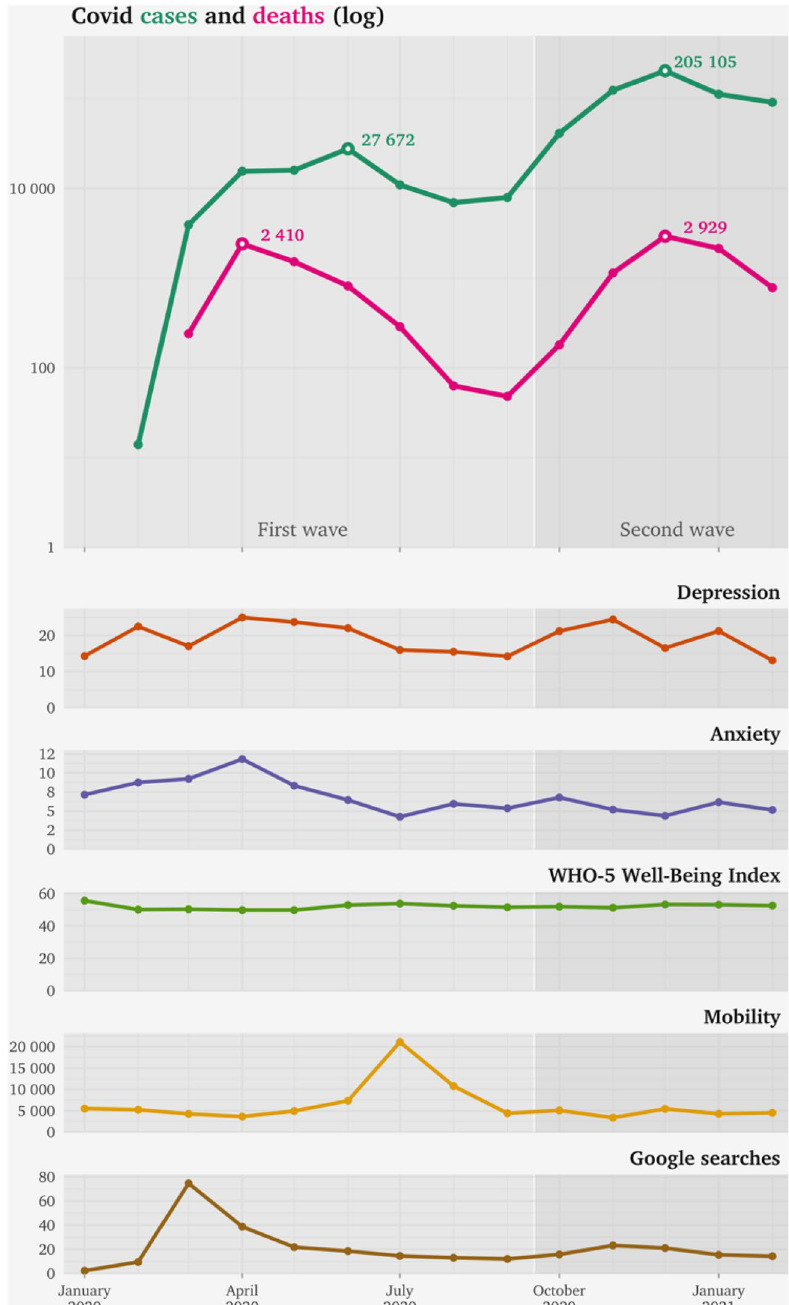
Figure 1. The figure presents log transformed number of cases with confirmed COVID-19 infection and deaths in Sweden from January 2020-February 2021 (top panel). The lower panel shows the proportion of women over the clinical cut-offs regarding symptoms of depression on the Edinburgh Postnatal Depression Scale (EPDS) and anxiety measured by three questions on the same scale (EPDS-3A), followed by the proportion of women with high wellbeing according to the Well-being index measured with the WHO-5, mobility index (the monthly median of the median distance travelled away from home /100) and google searches performed in Sweden for “Corona”, where 100 denotes the timepoint for the peak popularity for the search term and 50 means that the term is half as